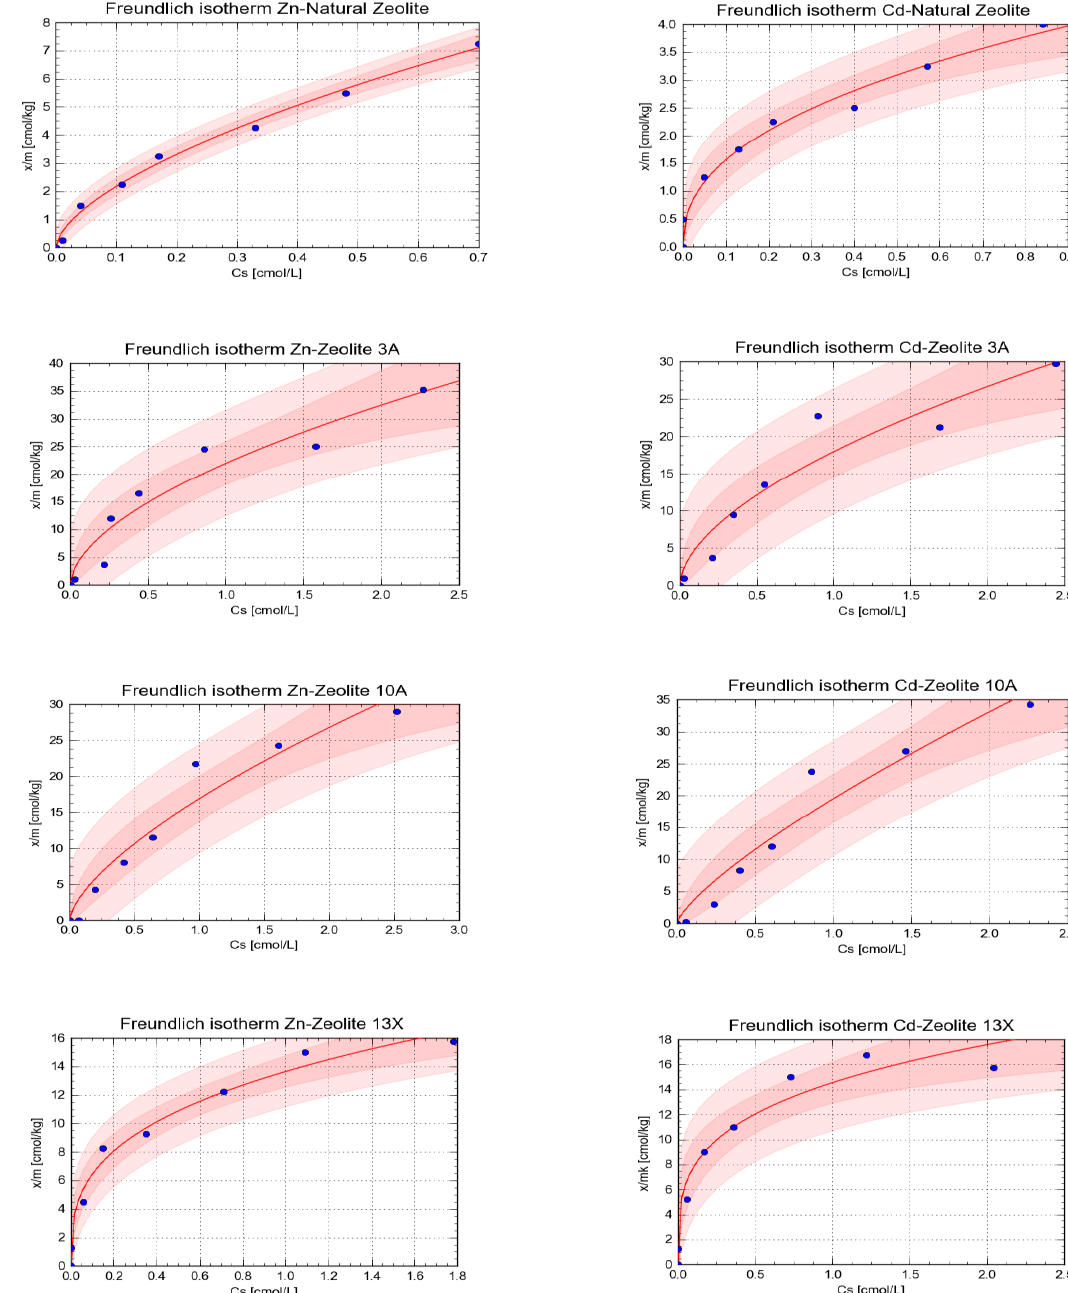
Figure 2. The Freundlich isotherms obtained in the study for sorption of Zn 2+ and Cd 2+ onto tested natural and synthetic zeolites.